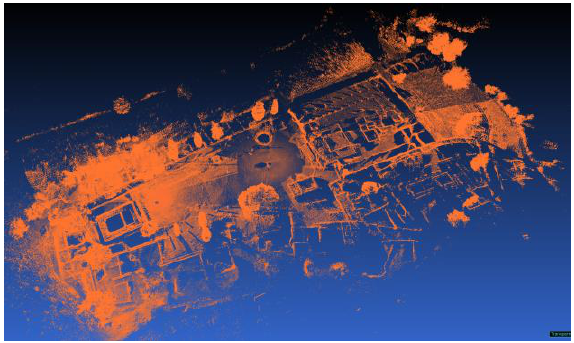
Figure 3. The geo-referenced final model (Cyclone 8.0.2)